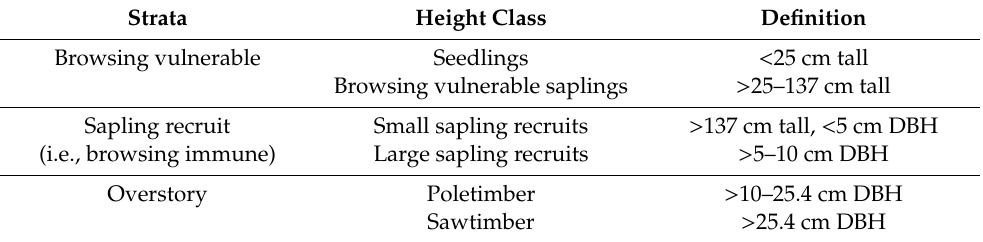
Table 1. Size classes of tree regeneration and strata used for stem count data.